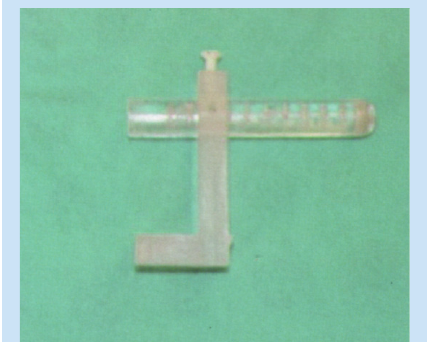
Fig. 1. The vaginal obturator (indigenously designed).